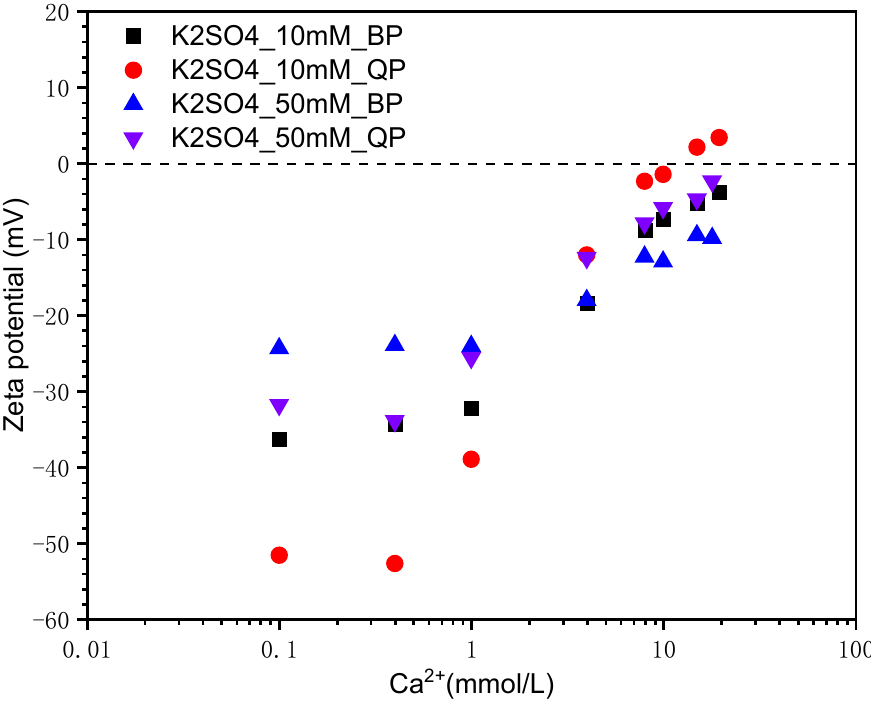
Figure 6. Zeta potential of BP and QP in the mixed solution of K 2 SO 4 + Ca(OH) 2 .